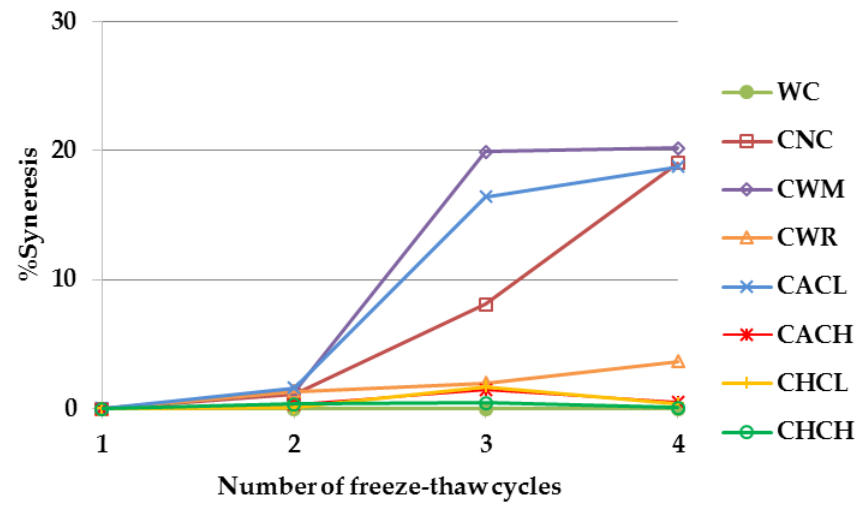
Figure 7. Freeze-thaw stability of 5% gels from Thai non-GM bred waxy cassava starch (WC), commercial normal cassava starch (CNC), commercial waxy maize starch (CWM), commercial waxy rice starch (CWR) and commercial acetylated cassava starches with low and high degrees of substitutions (CACL and CACH) and commercial hydroxypropylated cassava starches with low and high degrees of molar substitutions (CHCL and CHCH) during storage at –18 ℃ for 4 weeks.